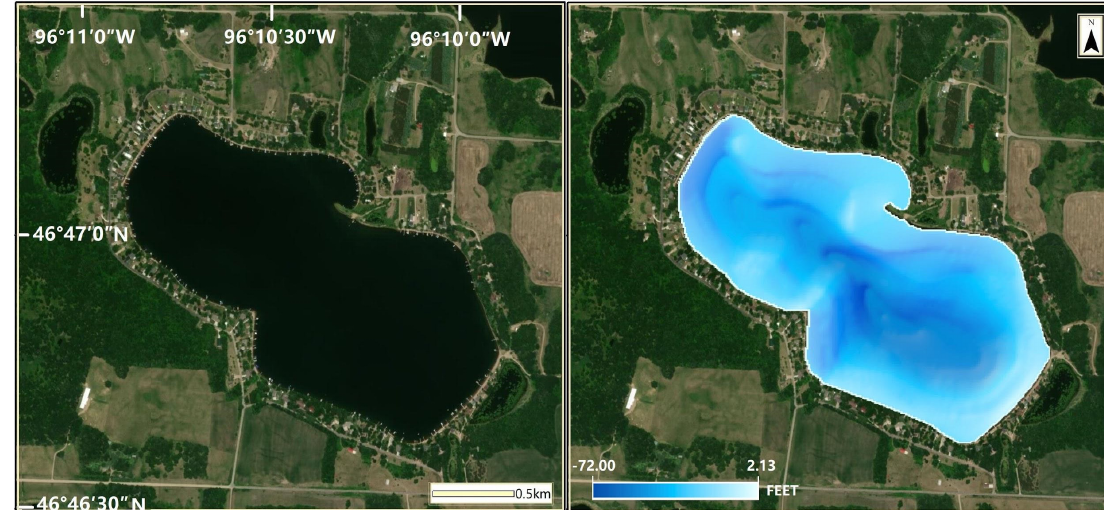
Figure 3. An example of the lake bathymetric DEM of Turtle Lake in the state of